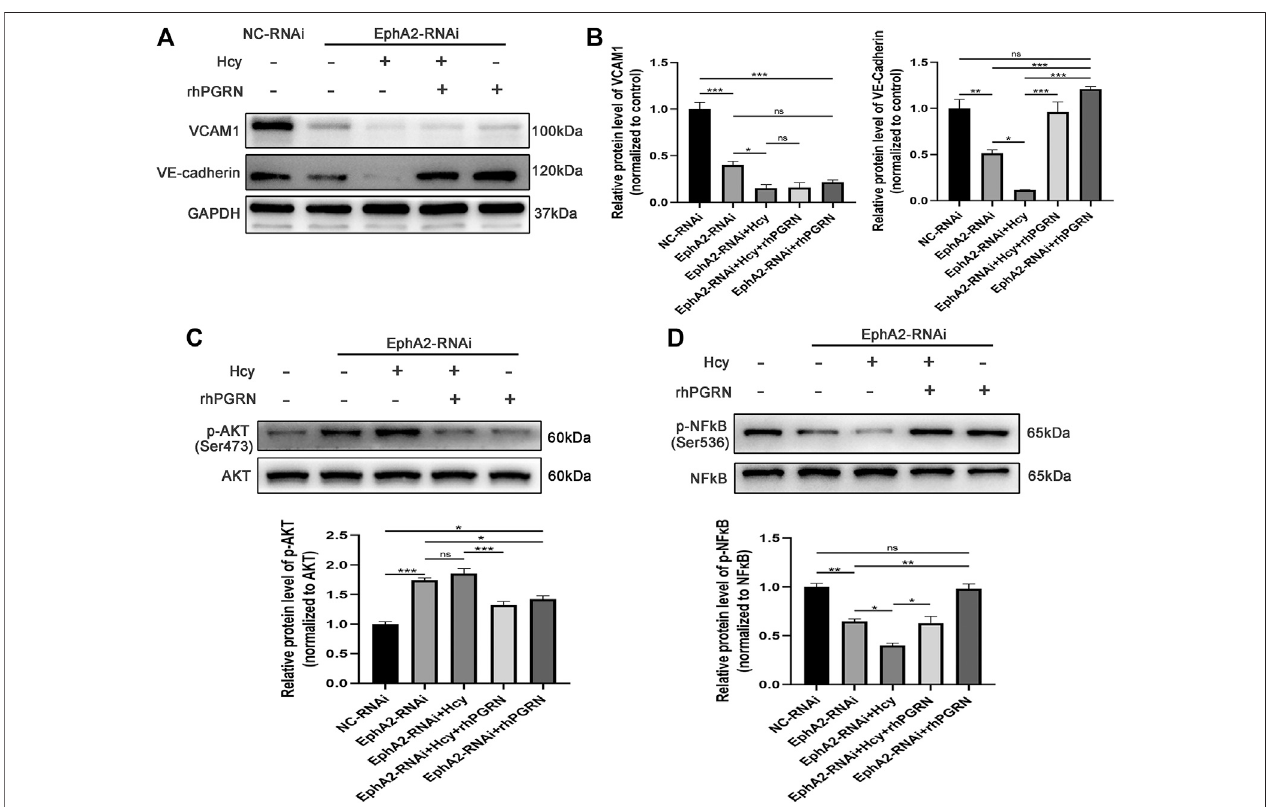
FIGURE 6 | Effects of rhPGRN combined with shRNA interference of EphA2 on adhesion molecules and cytokines and NF- κ B p65 and AKT pathways in Hcy- injured HUVECs. (A) Cells interfered with EphA2-shRNA (EphA2-RNAi) or NC-shRNA (NC-RNAi), and then the EphA2-RNAi group was treated with Hcy 2.0 mM, 200 ng/mLrhPGRN,Hcy+rhPGRNfor24 h.RepresentativeWesternblottingresultsofproteinlevelsofVE-cadherinandVCAM1betweengroups. (B) Thesummarized dataoftheproteinlevelsofVCAM1andVE-cadherin (C) RepresentativeWesternblottinggeldocumentsandsummarizeddatashowingthelevelsofphospho-AKT (Ser473)andtotalAKT. (D) Representativewesternblotgeldocumentsandsummarizeddatashowingthelevelsofp-NF- κ Bp65(Ser536)andtotalNF- κ Bp65.Dataare presented as means ± SEM (* p < 0.05, ** p < 0.01, *** p < 0.001 vs. NC-RNAi group, ANOVA, n (cid:1) 3). NC: negative control.